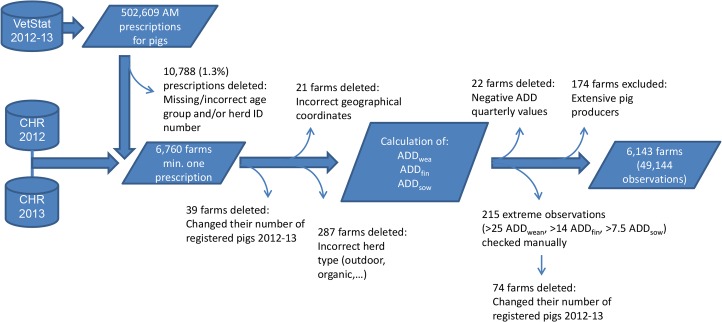
Flow diagram of data management.Data extracted from the Danish national databases VetStat and CHR were used to calculate up to three standardized measures of antimicrobials for each pig farm (ADDwea, ADDfin and ADDsow). AM = antimicrobials.